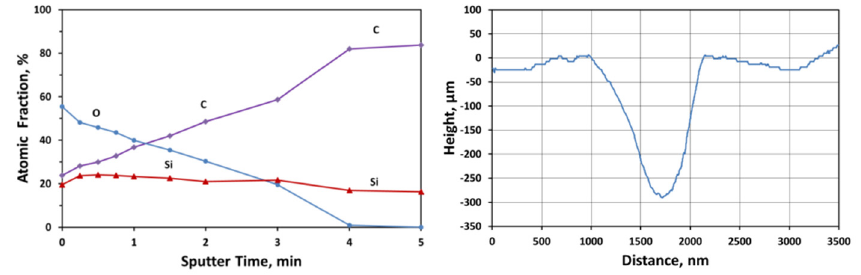
Figure 5. ( left panel ) Composition of 30 A sample as a function of 10 keV Ar 2500+ sputter time and ( right panel ) a profile of the crater obtained by 10 keV Ar 2500+ sputtering for 5 min.